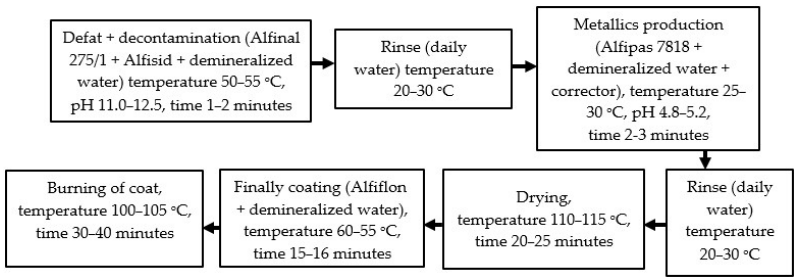
Figure 2. The scheme of sketch projection of the production multilayer micro-coating on the Al forms with description individual specification of technological parameters.